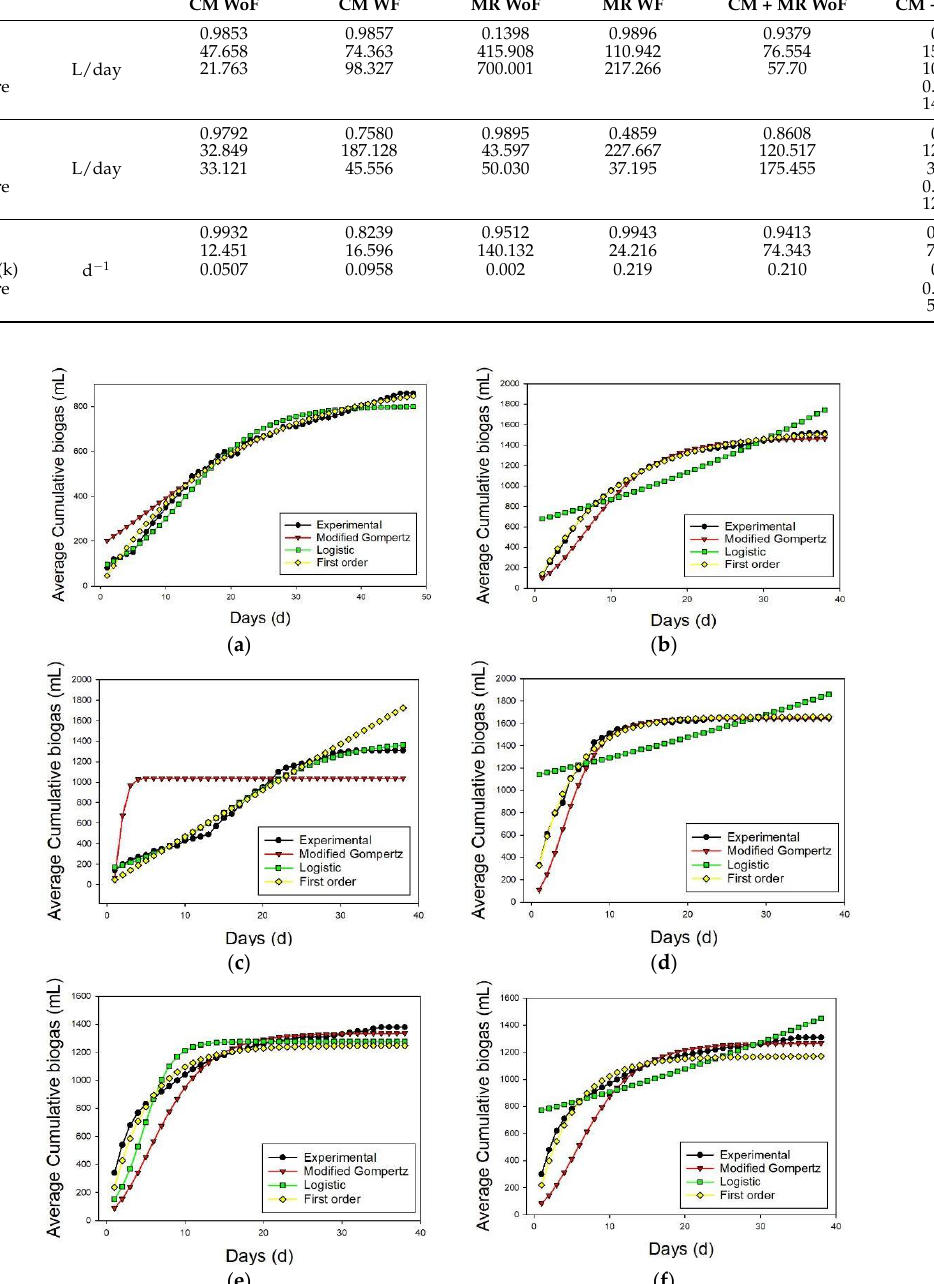
Figure 9. Kinetic study for CM, MR, and CM + MR (average from 18 bottles): ( a ) CM WoF, ( b ) CM F, ( c ) MR WoF, ( d ) MR F, ( e ) CM + MR WoF, ( f ) CM + MR